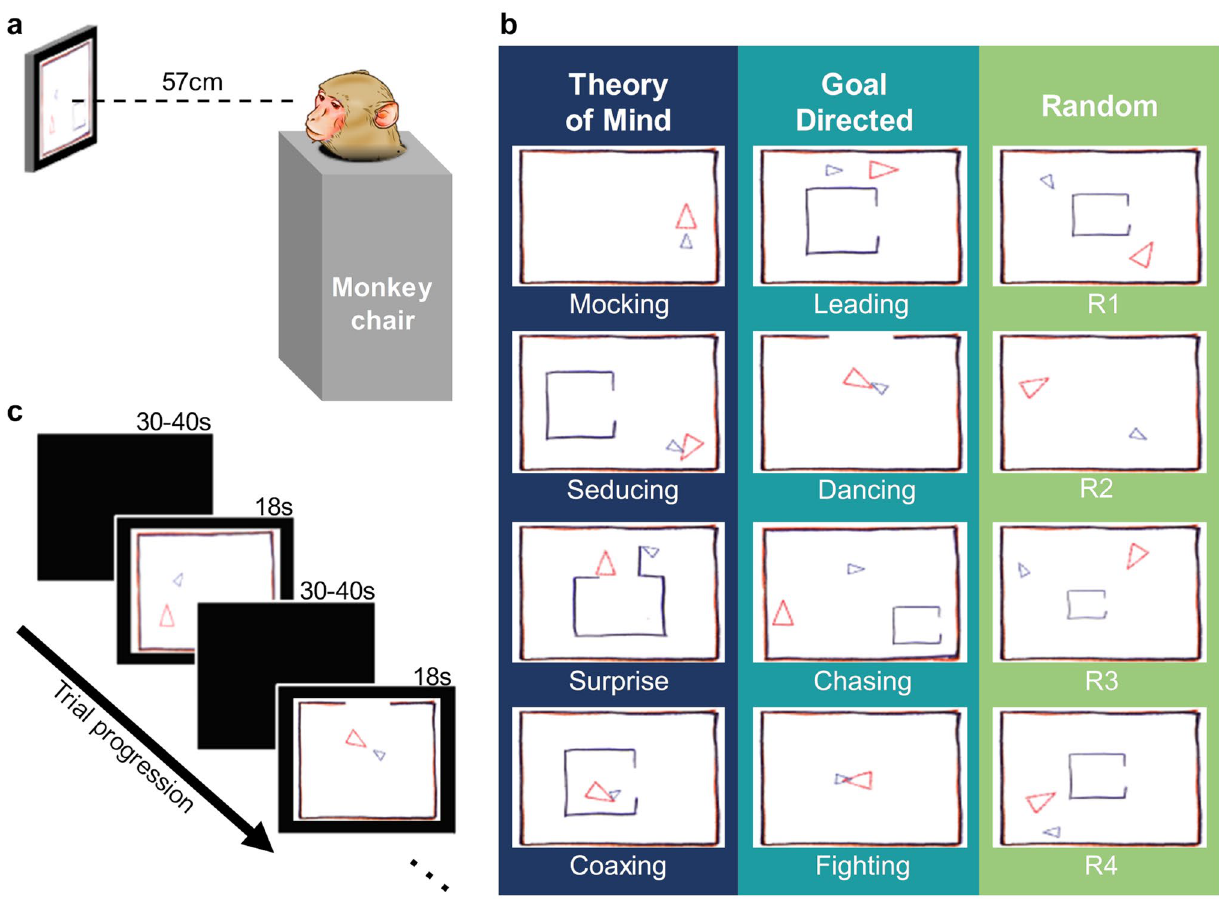
Figure 1. Monkeys freely viewed the Heider–Simmel animations. ( a ) While seated in a primate chair with heads fixed, monkeys viewed 12 animations lasting 18 s each. ( b ) Abell et al. 7 animations categories: Theory of Mind, Goal Directed, and Random. Each category was composed of four videos. ( c ) Monkeys viewed the animations in a random order with 30–40 s intertrial To thoroughly examine the data, we next looked at the performance of each individual monkey (Fig. 3). Five of the six monkeys showed no significant difference between categories (Monkey SK: F (2, 76) = 0.68, p = 0.51; Monkey SP: F (2,94) = 0.23, p = 0.80; Monkey LD: F (2, 300) = 2.32, p = 0.10, Monkey CP: F (2, 233) = 0.71, p = 0.50; Monkey CN: F